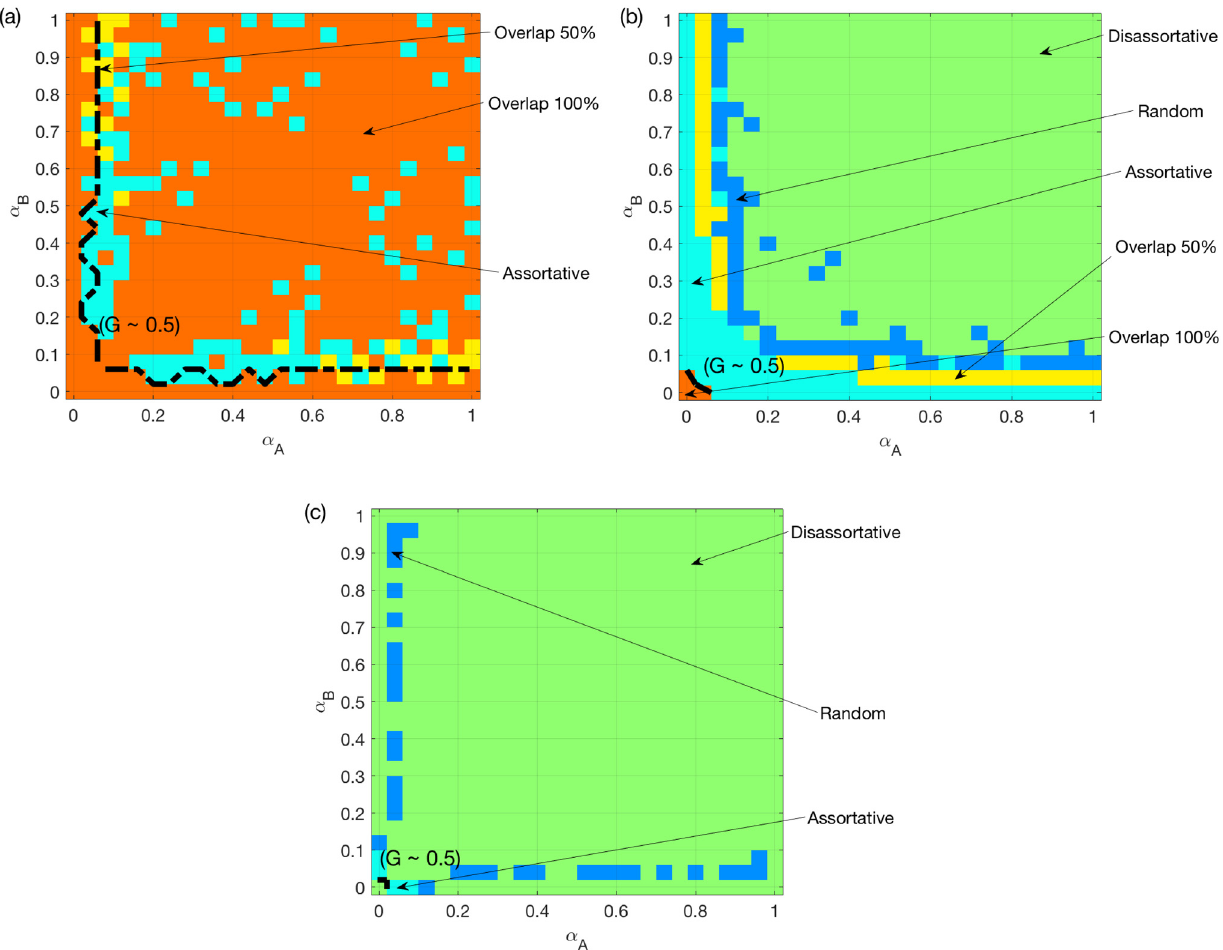
Fig 6. Best choice of coupling schemesfor two ER networks. (a) OR rule. (b) SUM rule. (c) AND rule. N = 500, k A = k B = 6, averaged over M = 50 realizations. The color for certain α A and α B values indicatesthe best couplingscheme having the largest mean G value. A dashedline is added to each sub-figure to indicatethe locationwhere the best mean G reaches0.5.